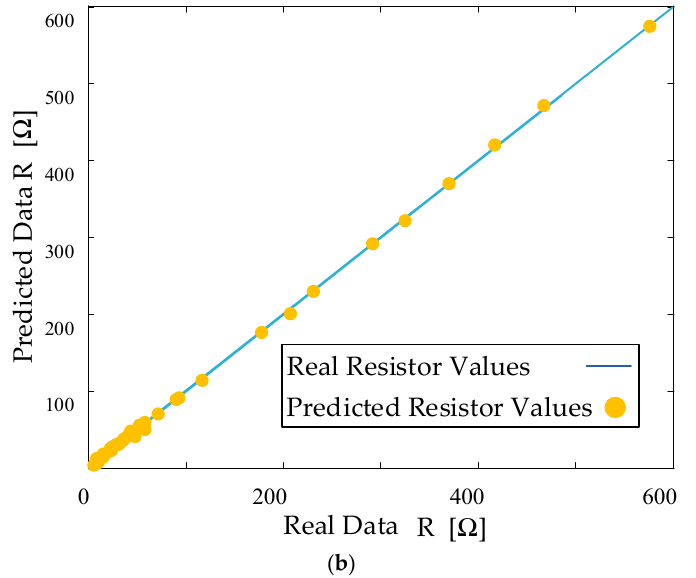
Figure 8. Real and predicted circuit output resistor values for ( a ) test and ( b ) train data of the final proposed ANN–PSO network.